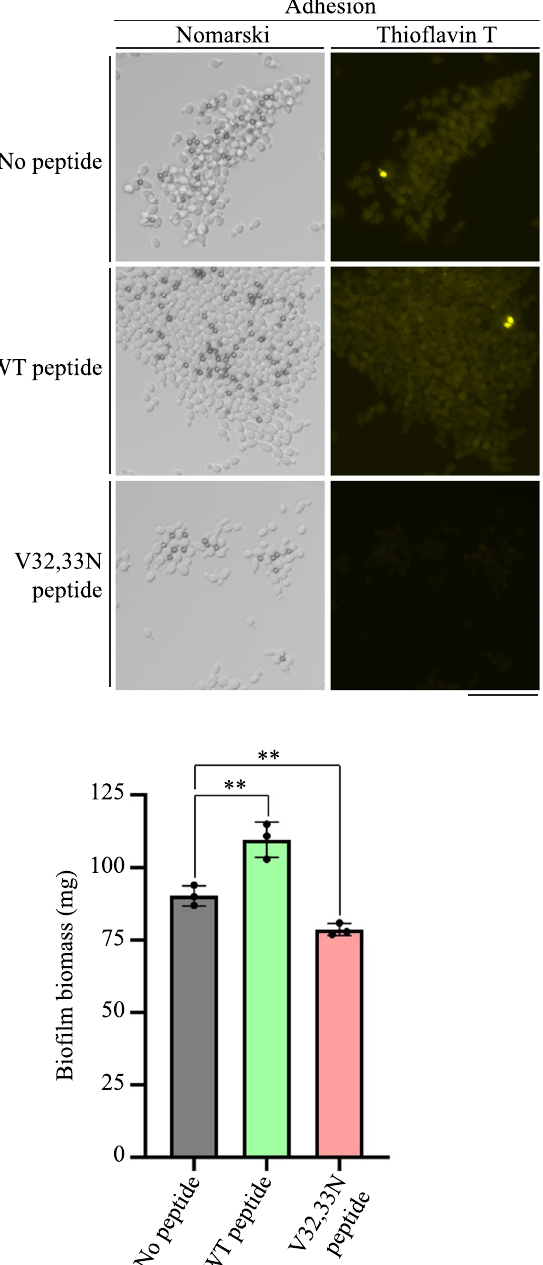
Fig. 7 Amyloid assembly and bio fi lm formation are impaired upon treatment with the Pga59 D1 V32,33N peptide. a Amyloid assembly upon adhesion was assessed by incubating a WT strain of C. albicans with magnetic beads, ThTand either the Pga59 WT D1 peptide (middle panels) or the V32,33N mutant version (bottom panels). Adherent cells without peptide treatment were used as a control (top panels). The ThT fl uorescence was observed with an epi fl uorescence microscope. Scale bar: 25 μ m. The experiment was performed three times. b Bio fi lms of the WT C. albicans strain were grown in TPP ® six- well culture plates in RPMI medium in the presence of either the Pga59 WT peptide or the V32,33N peptide. Bio fi lms incubated without Pga59 peptides were used as a control. After 48h, bio fi lms were washed, dried, and subsequently weighed. For each experimental condition, values are average ±SD. (**) p < 0.01. The quanti fi cation of three independent experiments is presented on the histogram. The signi fi cance of the results was evaluated using a Student ’ s t -test. Source data are provided as a Source Data fi